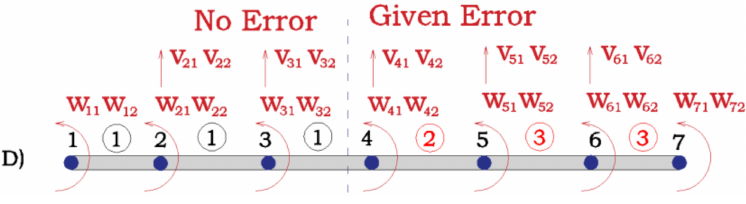
Figure 8. Measurement set